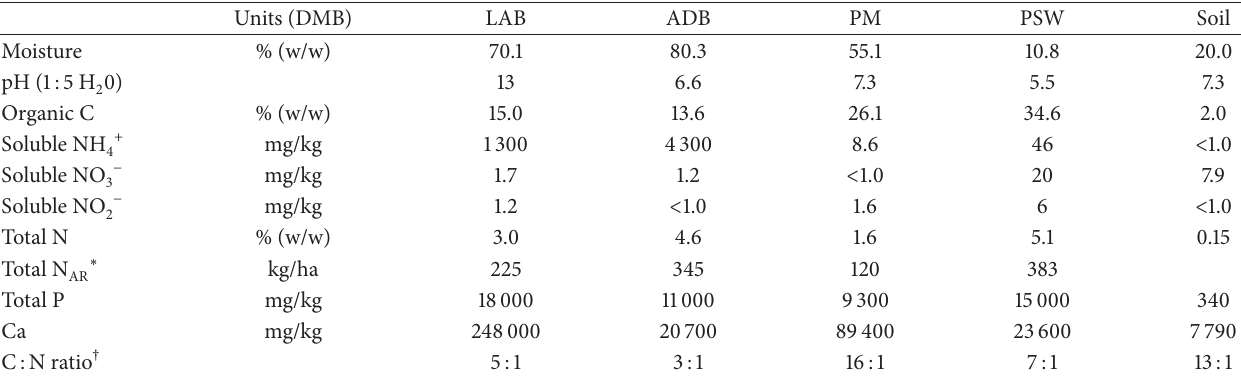
Table 1: Chemical characteristics of bioresources and